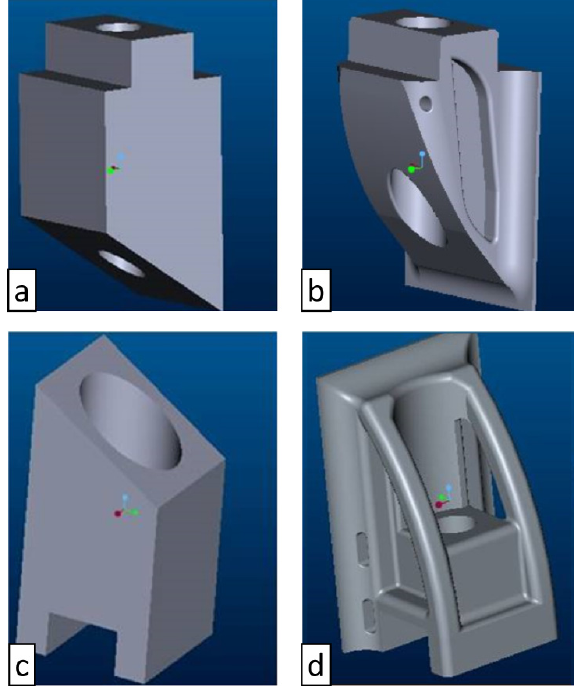
Figure 9. Original design ( a ) and AM redesign ( b ) of an upper junction point. Original design ( c ) and AM redesign ( d ) of a lower junction point.